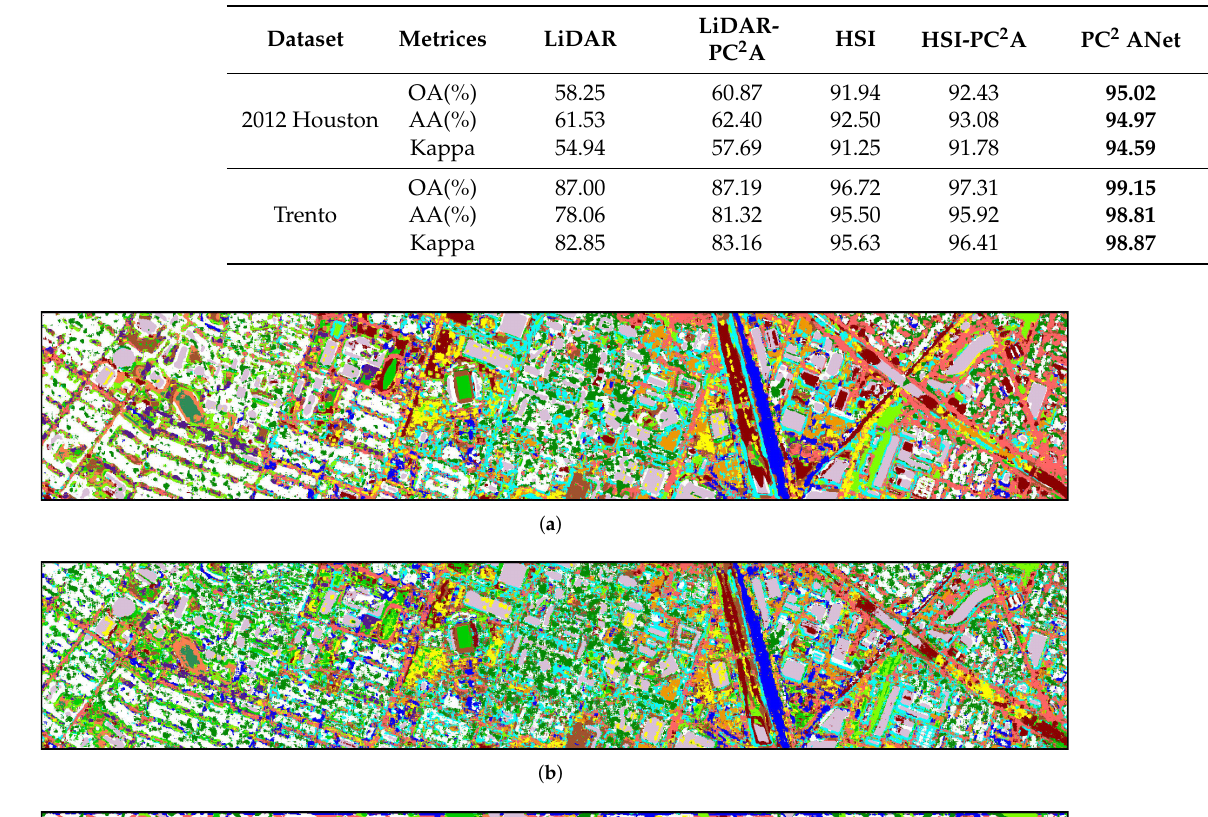
Table 3. Influence of PC 2 A on the Houston and Trento dataset.